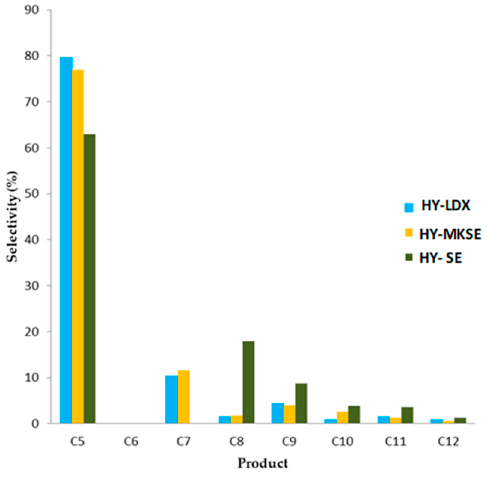
Figure 14. A comparison of percent conversion, yield and selectivity from zeolite HY.